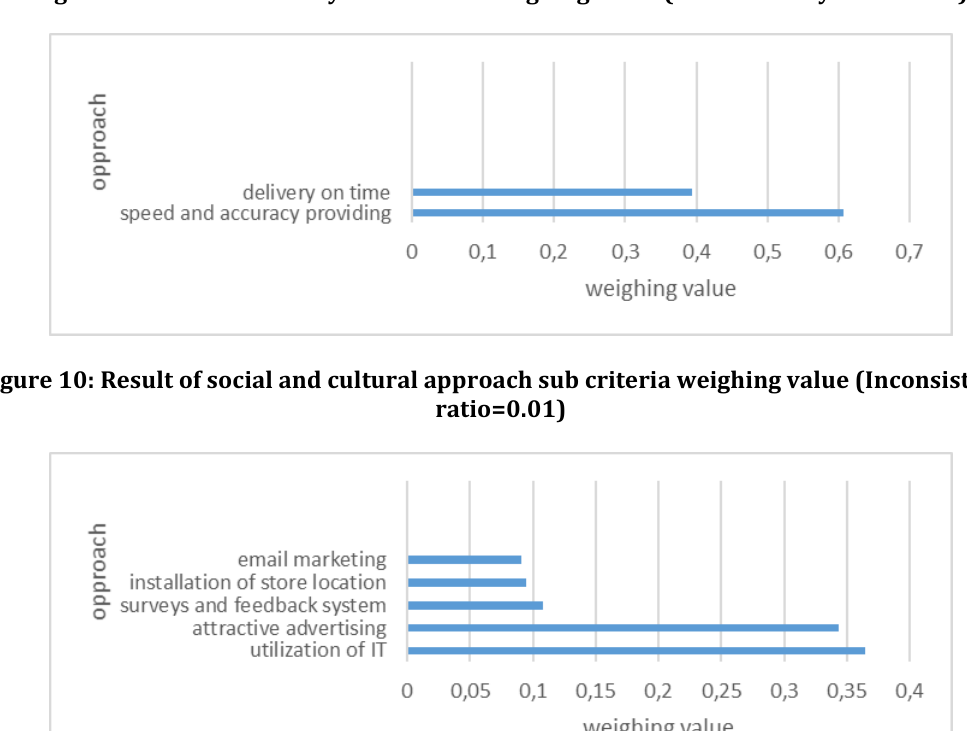
Figure 9: Result of delivery sub criteria weighing value (Inconsistency ratio=0.00)